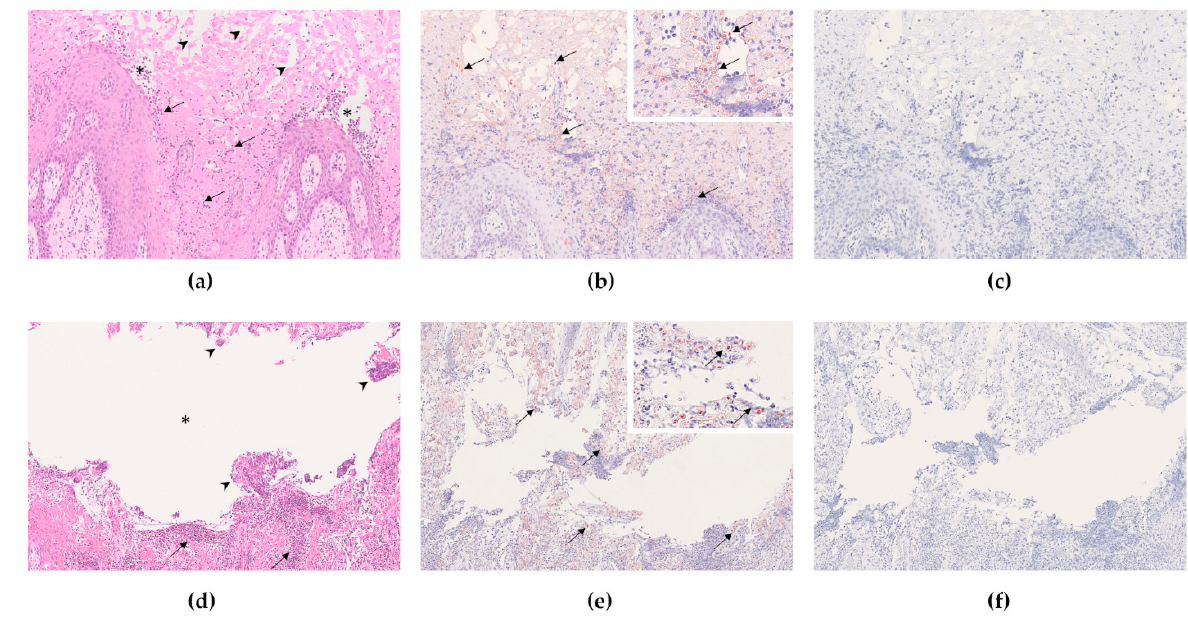
Figure 4. Postmortem findings after injection of naked FMDV RNA into the tongue. All six cattle in the first animal trial developed severe clinical signs of FMD and pathognomonic findings were made at necropsy (arrows): ( a ) lesions on the tongue, corresponding to the areas of injection, and on the upper gums; ( b ) lesions on the tongue, the upper and lower gums; ( c ) large, mostly intact lesion in the interdigital space; ( d ) the true extent of the lesion is revealed after manipulation.